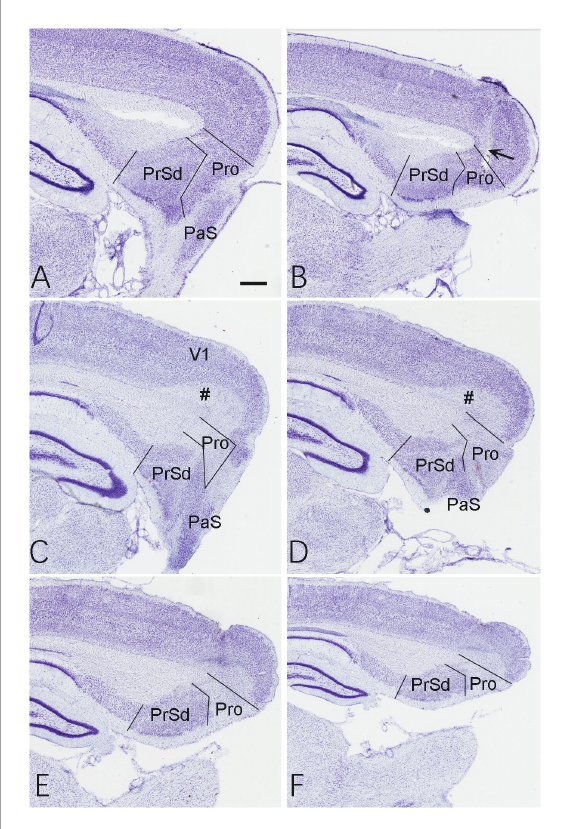
FIGURE2 Evaluation of the lesion and its extent. (A,B) Two Nissl-stained sagittal sections from the lateral (A) and middle (B) levels of the prostriata and adjoining regions in the sham group. The arrow in panel (B) indicates a needle track of the injection. (C–F) Sequential Nissl-stained sagittal sections from lateral (C) to medial (F) levels of the prostriata and adjoining regions in the experiment group. The #s in panels (C,D) indicate layer 6 of the V1. Bar in panel (A) : 400 µ m for all